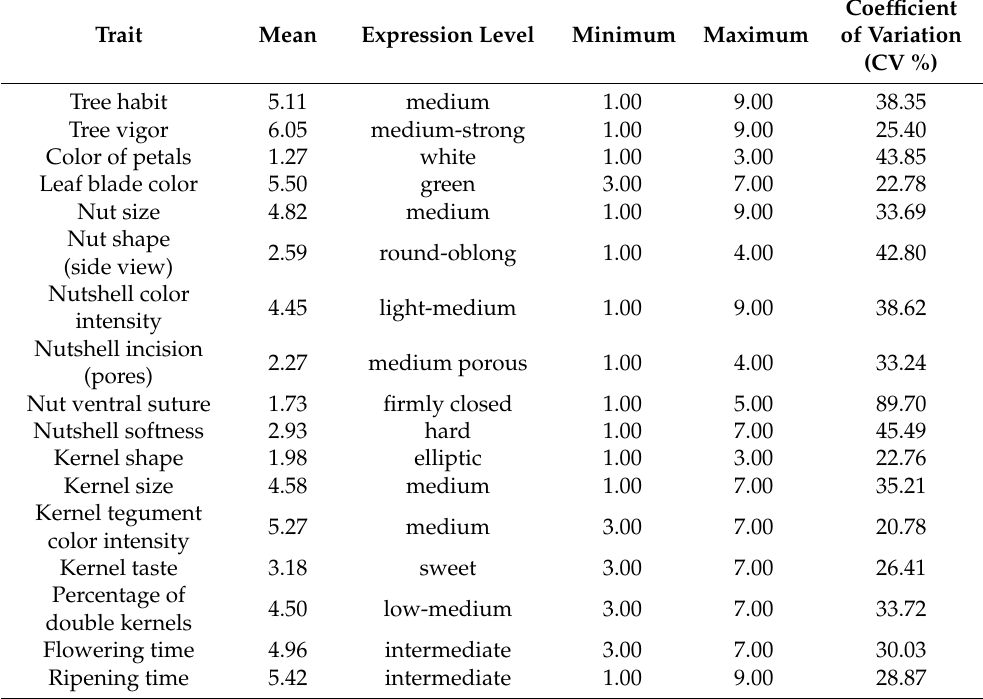
Table 3. List of morphological and phenological traits detected in the almond collection and their descriptive